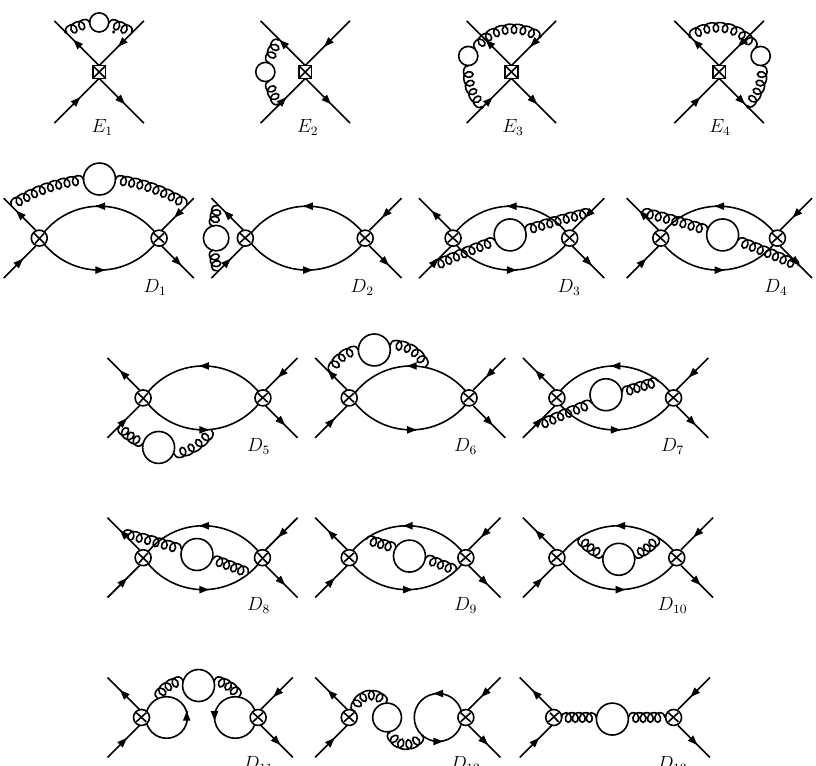
2 N f ) corrections to eq. (2.6) . E 1 E 4 are the s − , E ′ , D ′ , D ′ , D ′ , D ′ , D ′ , 1 2 1 2 5 6 7 /m 2 c b